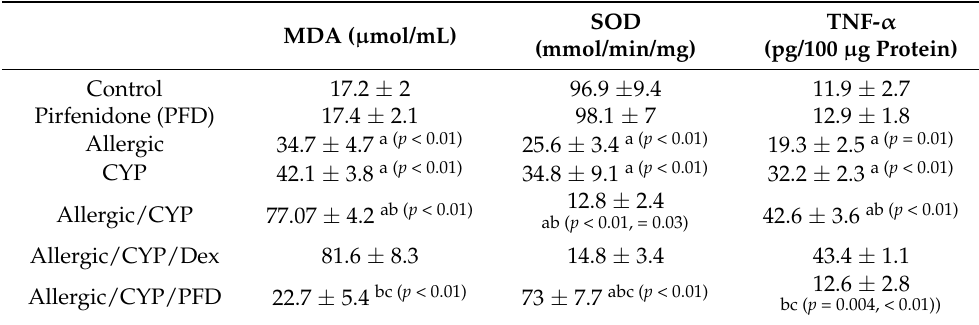
Table 3. The effect of pirfenidone on the lung tissue concentrations of MDA, SOD, and TNF- α in CYP-exposed allergic pneumonitis rats at the end of the